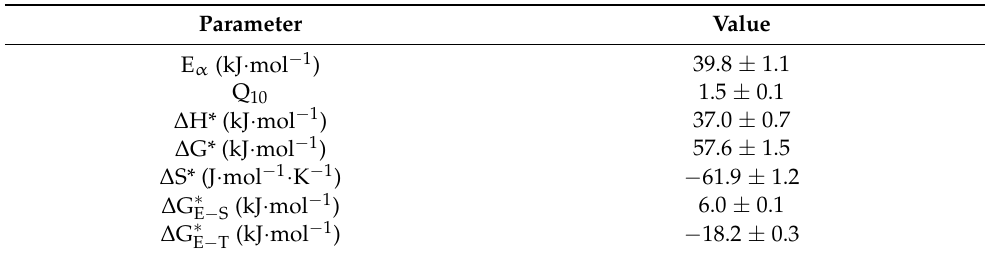
Table 3. A summary of the thermodynamic parameters (calculated at optimum temperature for activity, 60 ◦ C) for oat spelt xylan hydrolysis by